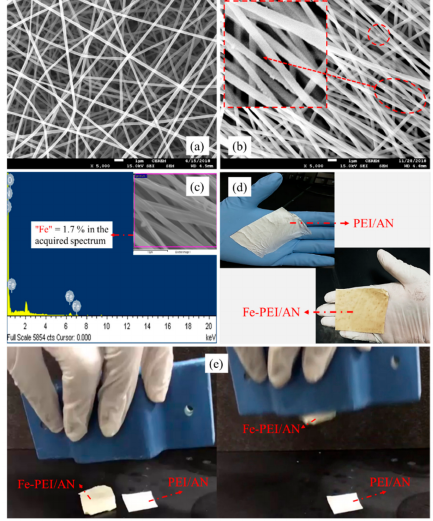
Figure 1. SEM and EDX images of prepared composite nanofibers membranes: ( a ) PEI-AN, ( b ) Fe/PEI-AN, ( c ) EDX of Fe/PEI-AN, ( d ) digital images of prepared membranes, and ( e ) magnetic properties of membranes with or without iron